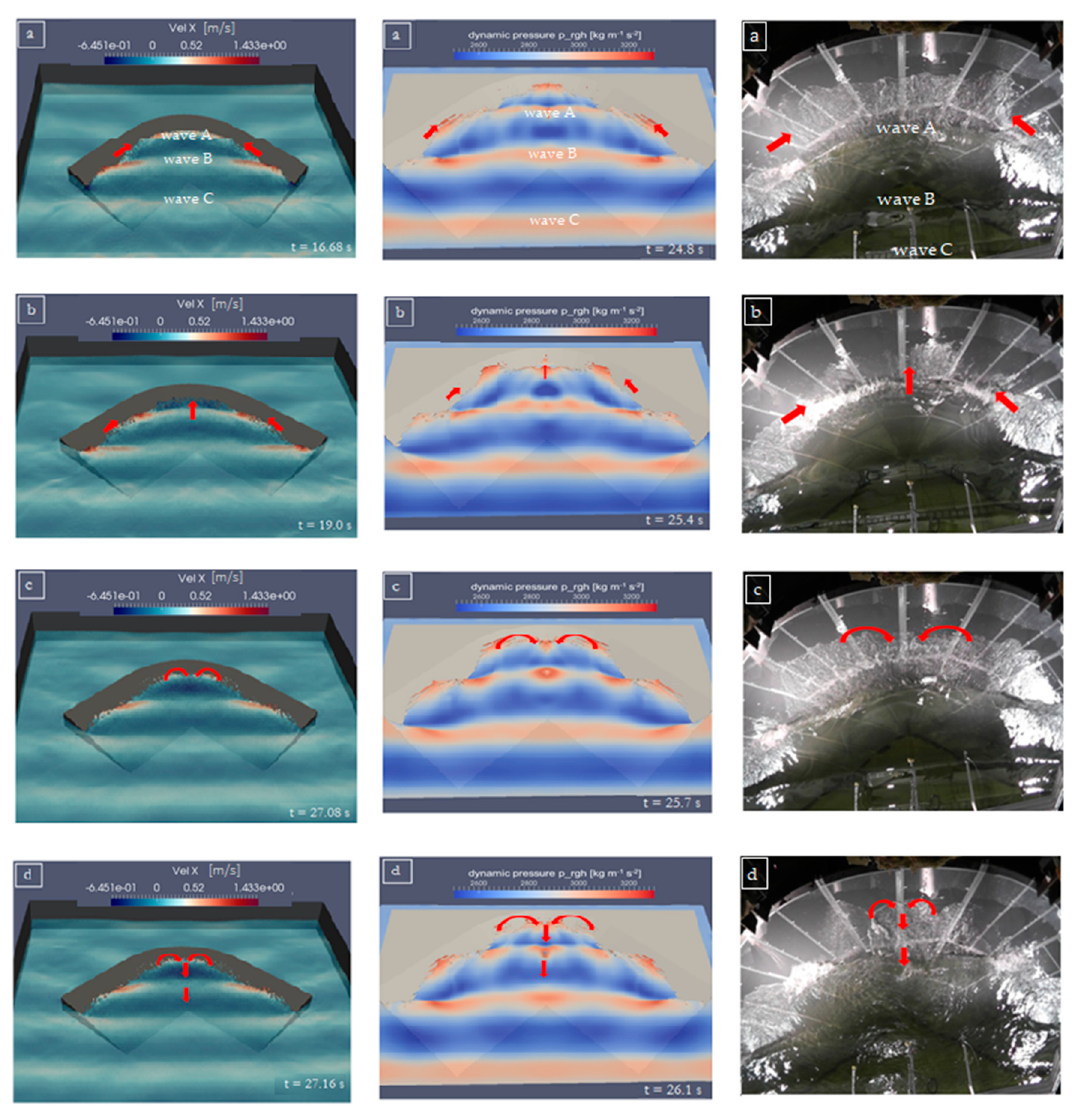
Figure 7. Wave transformation processes on a 90° concavely curved dike (Left: DualSPHysics, Middle: OpenFOAM, Right: Physical model); H = 0.10 m, T = 1.46 s, β = 0°.